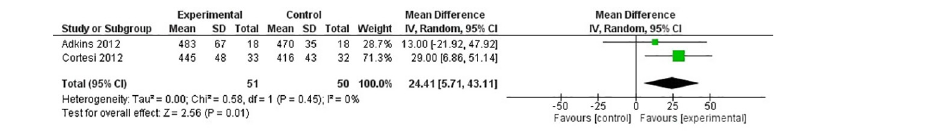
Fig 2. Actigraphy total sleep time (minutes) in children with ASD.